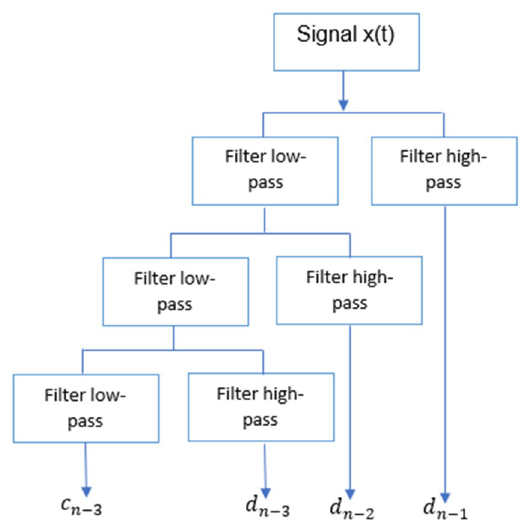
Figure 3. Discrete Wavelet Transform (DWT) decomposition. Table 1. Characteristics of different bioelectrical signals.